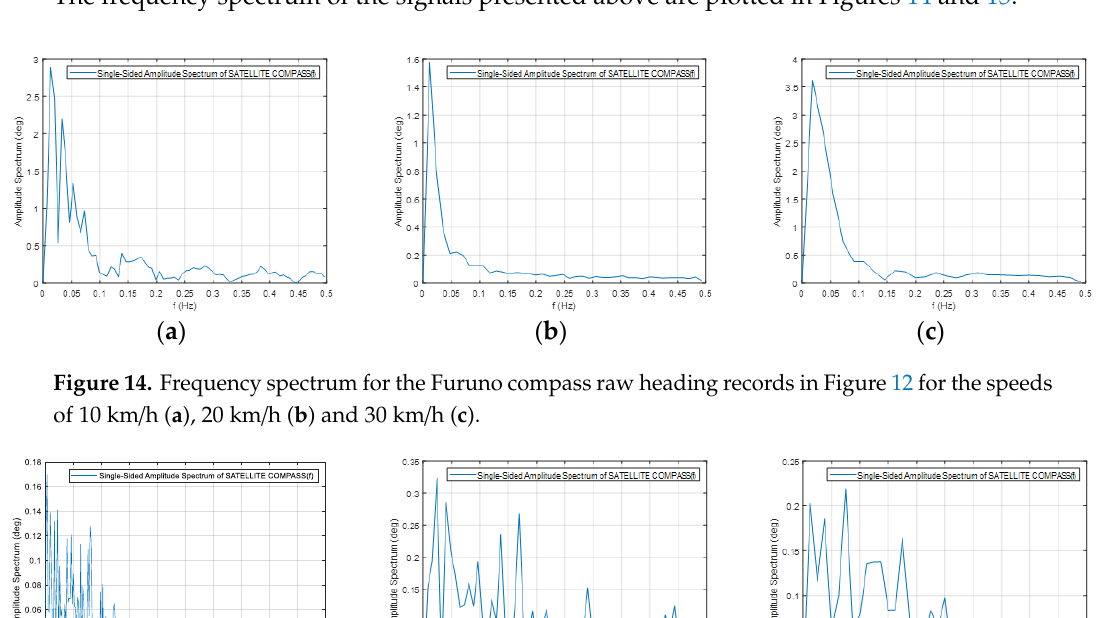
Figure 16. Raw heading value results during the stationary test with the Advance Navigation compass used as an example. The orange line denotes the satellite signals in the moment of being completely obscured.